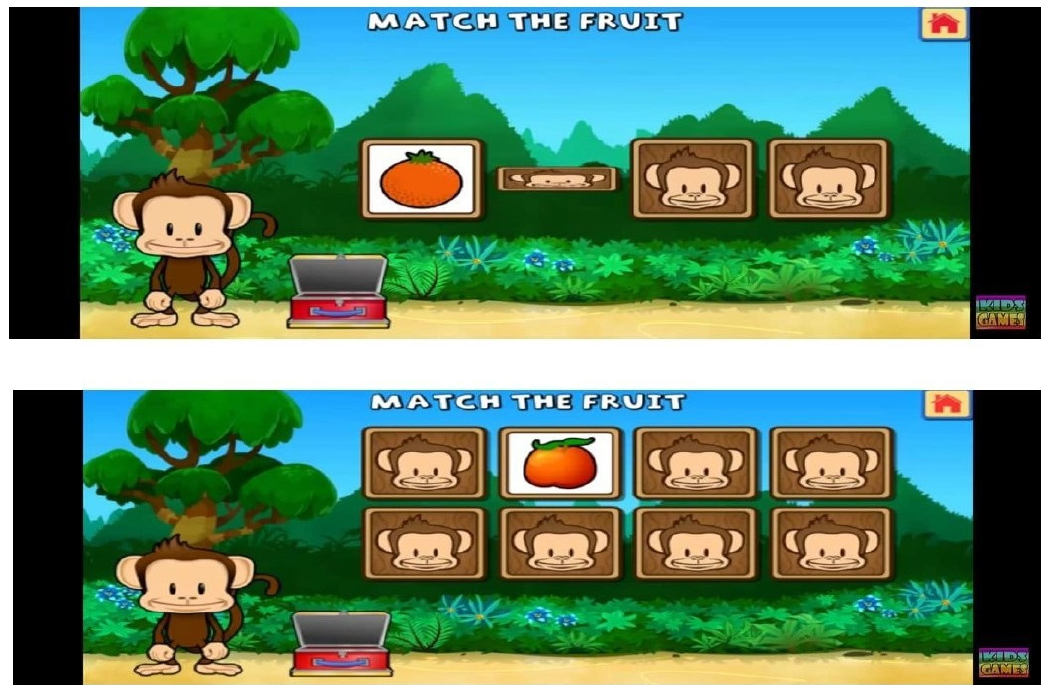
Figure 3. Mobile game without applying scaffolding